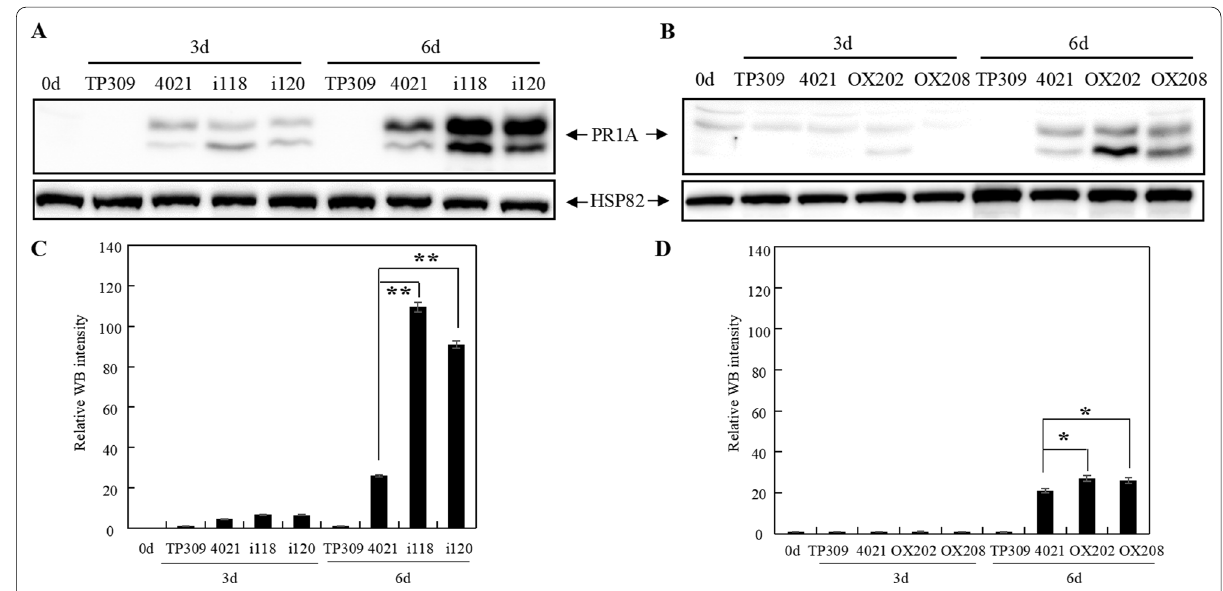
Fig. 10 Expression of PR1A in MPK17-regulated transgenic plants following Xoo inoculation. A Expression of PR1A protein in MPK17-RNAi transgenic rice after inoculated with Xoo . B Expression of PR1A protein in MPK17-OX transgenic rice after inoculated with Xoo . C Quantitative comparison of WB intensities of WRKY62 protein in panel ( A ). D Quantitative comparison of WB intensities of WRKY62 protein in panel ( B ). PR1A: anti-PR1A antibody detected band; HSP82: anti-HSP82 antibody detected band used as loading control. i118, i120: independent MPK17-RNAi transgenic lines; OX202, OX208: independent MPK17-OX transgenic lines; TP309: Japonica rice variety; 4021: transgenic TP309 line harboring the Xa21 gene. Signal of PR1A protein in panel ( A ) and ( B ) were detected by Mini Chemiluminescent Imager and Sage Capture software. Lane 1D software was used to extract signals of WB. Average was calculated for three repeats. Error bars are standard deviation (SD). * and **designate difference at p < 0.05 and p < 0.01 levels